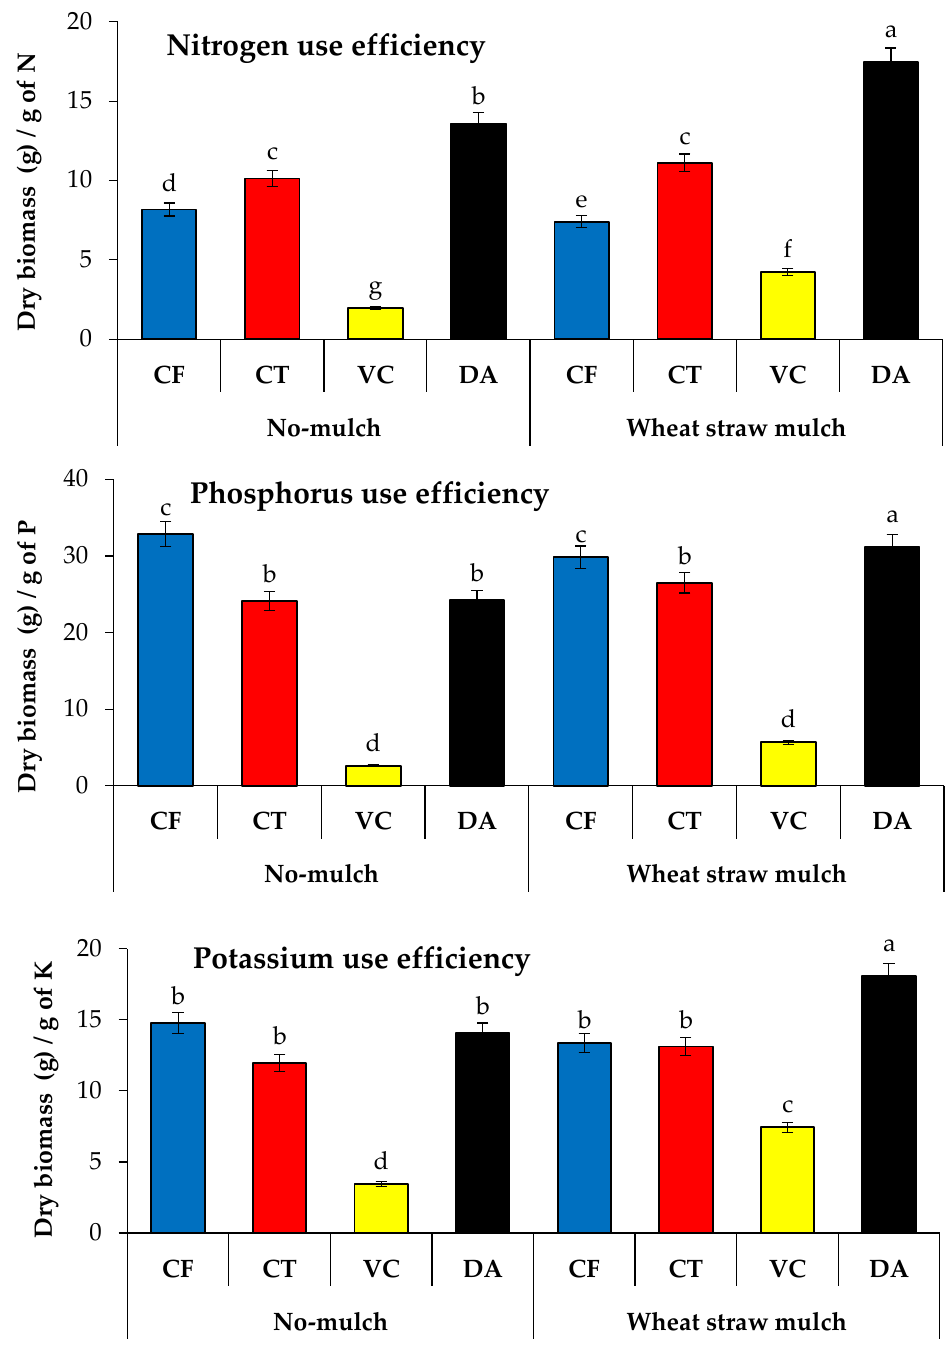
Figure 3. Effect of organic amendments and mulching system on nutrient use efficiency. CO = Control (without fertilization), CF = Recommended mineral fertilization (112 kg N ha −1 + 50 kg P 2 O 5 + 75 kg K 2 O ha −1 ), CT = Compost (7.5 t ha −1 ), VC = Vermicompost (7.5 t ha −1 ), DA = Dry Azolla pinnata (3.75 t ha − 1 ). Different letters indicate significant differences according to Duncan’s multiple range test at p ≤ 0.05. Data are means of three replicates ± SE.